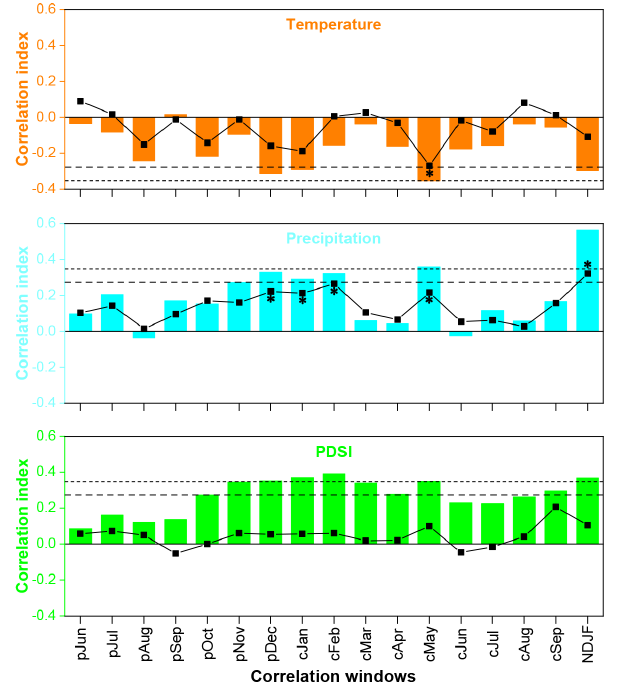
Figure 4. Correlations between tree-ring indices and tempera- ture, precipitation and scPDSI in the correlation windows from the previous-year June to current-year September, as well as in NDJF (non-growing season, NGS) for the common period from 1956 to 2005. The horizontal dashed and dotted lines indicate the thresh- old of the correlations at the 95% and 99% significance levels. The black line with squares denotes the results of response function analysis between tree-ring indices and climate variables. The aster- isks next to the squares denote the significant effects ( p < 0 . 05) of response function analyses.